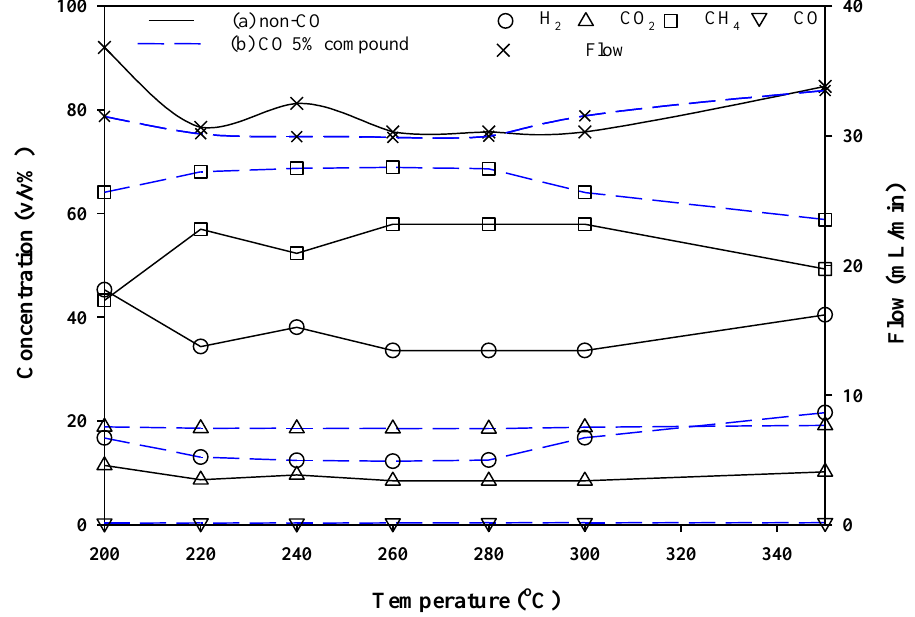
Figure 5. The composition of gases produced according to CO gas concentration (0 – 15%) in the CO 2 methanation reaction (1): (a) non-co (b) with CO 5% (Total inlet gas 120 mL/min).